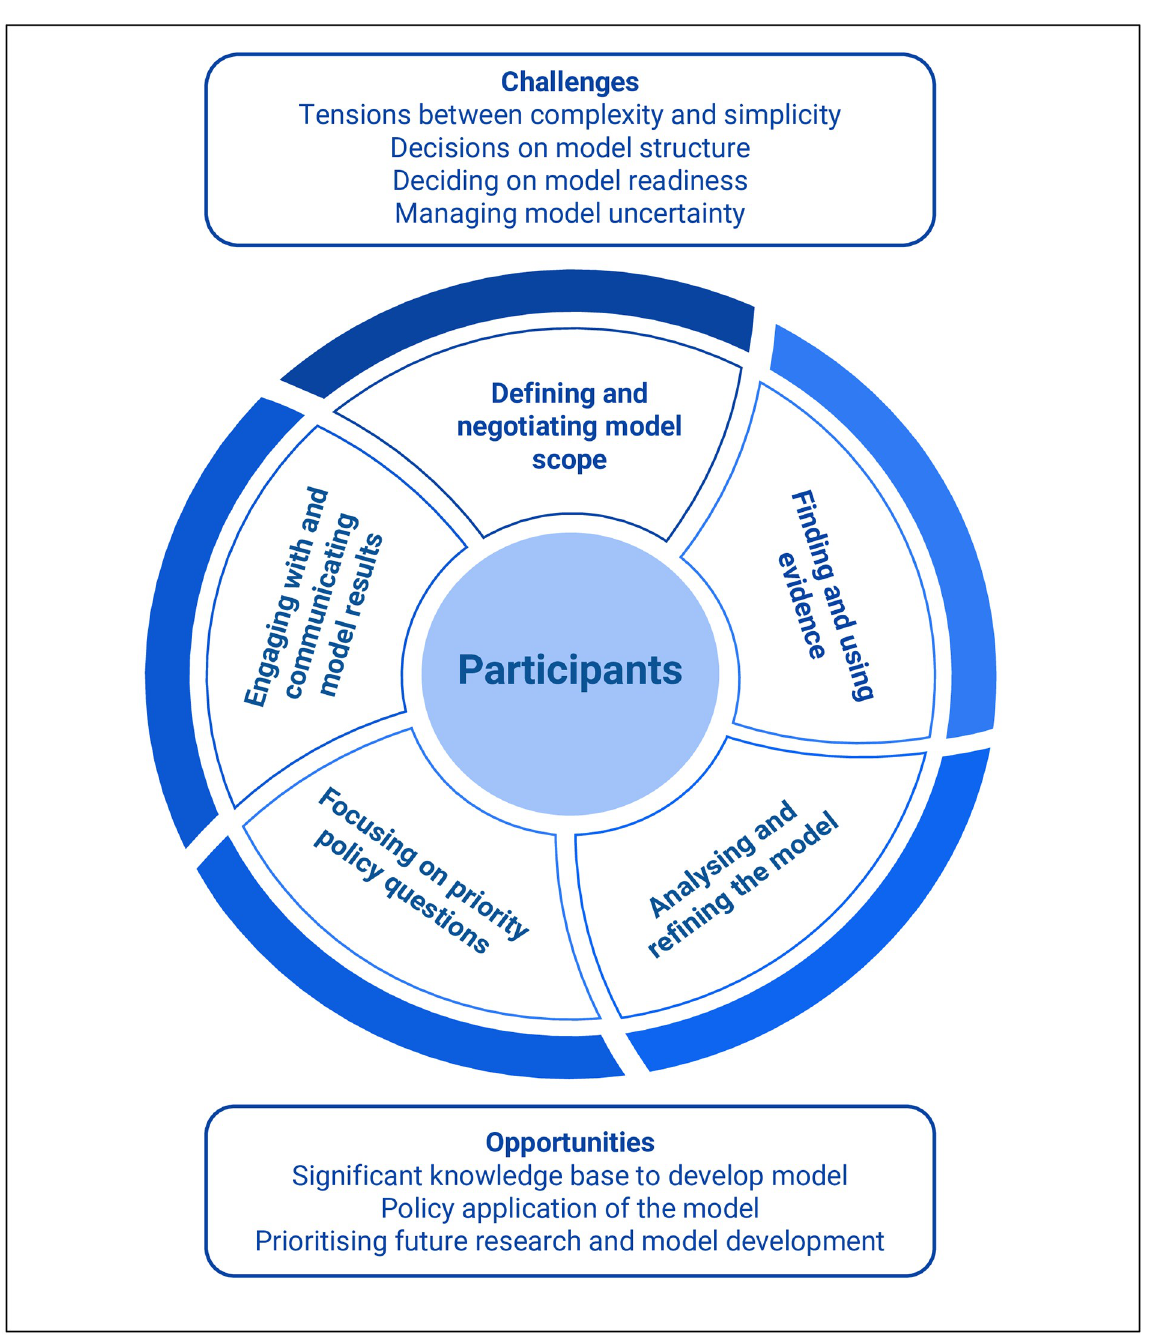
Fig 2. Overview of the analytical objectives and decision-making processes involved in the participatory development of a dynamic simulation model.